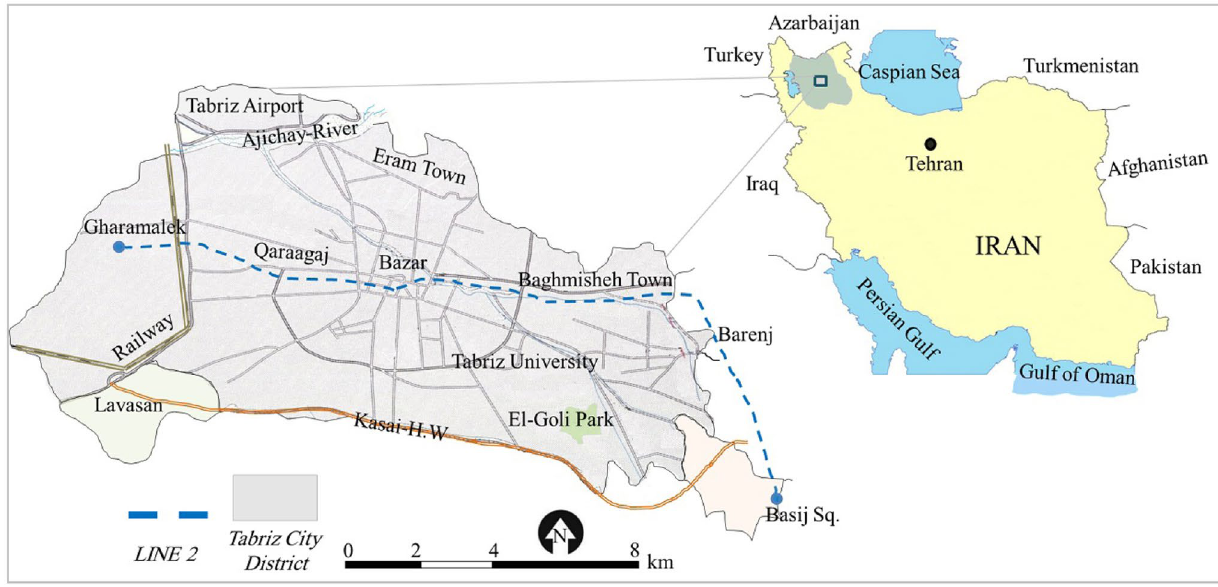
Fig. 2 Location of the study area in the northwest corner of Iran and TML2 route from the eastern to the western margins of the city